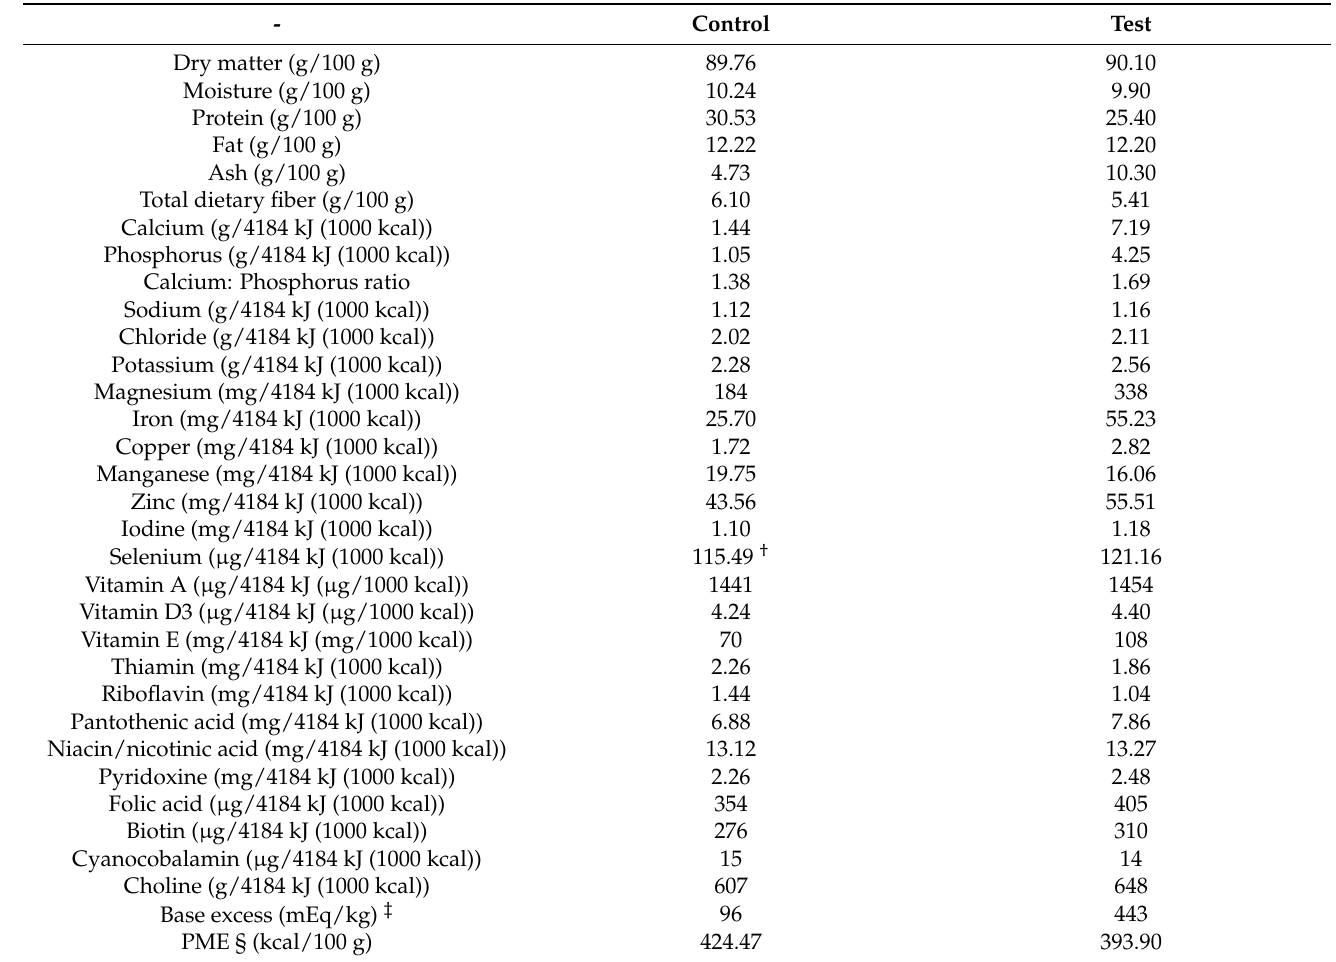
Table 1. Nutrient composition of the control and test diet. Diet analysis performed at the Mars Petcare Europe Central Laboratory. The analysis used three samples (each sample analyzed in triplicate) from different parts of a 2 kg batch of diet. The values presented in this table are averages and are within conformance